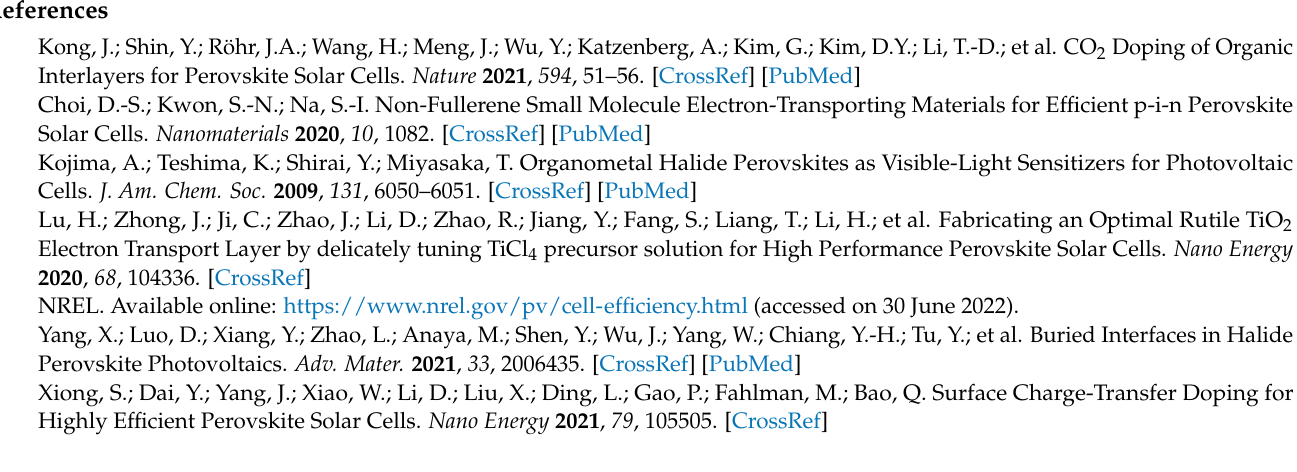
Figure S2. Fitted curves of the Fe 2P 3/2 of Fe 2 O 3 films prepared by different methods; Figure S3. UV–vis absorption spectra of Fe 2 O 3 films prepared by different methods; Figure S4. XRD patterns of perovskite coated on different substrates; Figure S5. J-V curves of PSCs based on Fe 2 O 3 and TiO 2 ETLs; Figure S6. Hysteresis measurement of PSCs based on Fe 2 O 3 prepared by different methods; Figure S7. Current − voltage curves of the PSCs with a structure of ITO/HTMs/perovskite/spiro-OMeTAD/Ag; Figure S8. Leakage current measurement of PSCs based on the Fe 2 O 3 ETLs prepared by different methods; Figure S9. Transmittance spectra of TiO 2 and Fe 2 O 3 films prepared by different methods. Figure S10. The continuous illumination stability of the TiO 2 and mixed Fe 2 O 3 based devices under UV illumination without encapsulation; Table S1. Summary of photovoltaic parameters of the PSCs based on the control TiO 2 ETLs and Fe 2 O 3 ETLs prepared by different methods (30 devices tested in the reversed direction); Table S2. Summary of the fitted parameters of solar cells based on the Fe 2 O 3 ETLs prepared by different